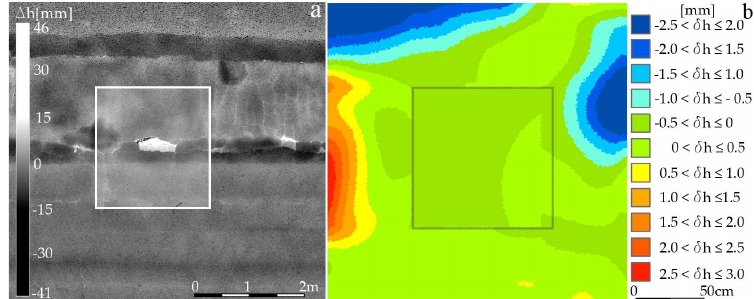
Figure 18. ‘Boundary effect’. (a) A sample of point cloud belonging to a central stretch of road; the area squared in white is the one subject to analysis; the grayscale is proportional to the roughness value ∆ h . (b) Classified map of the difference in roughness δ h computed for the points in the white square of (a). The area within the black box is not influenced by the boundary effect, the area outside the box it is.